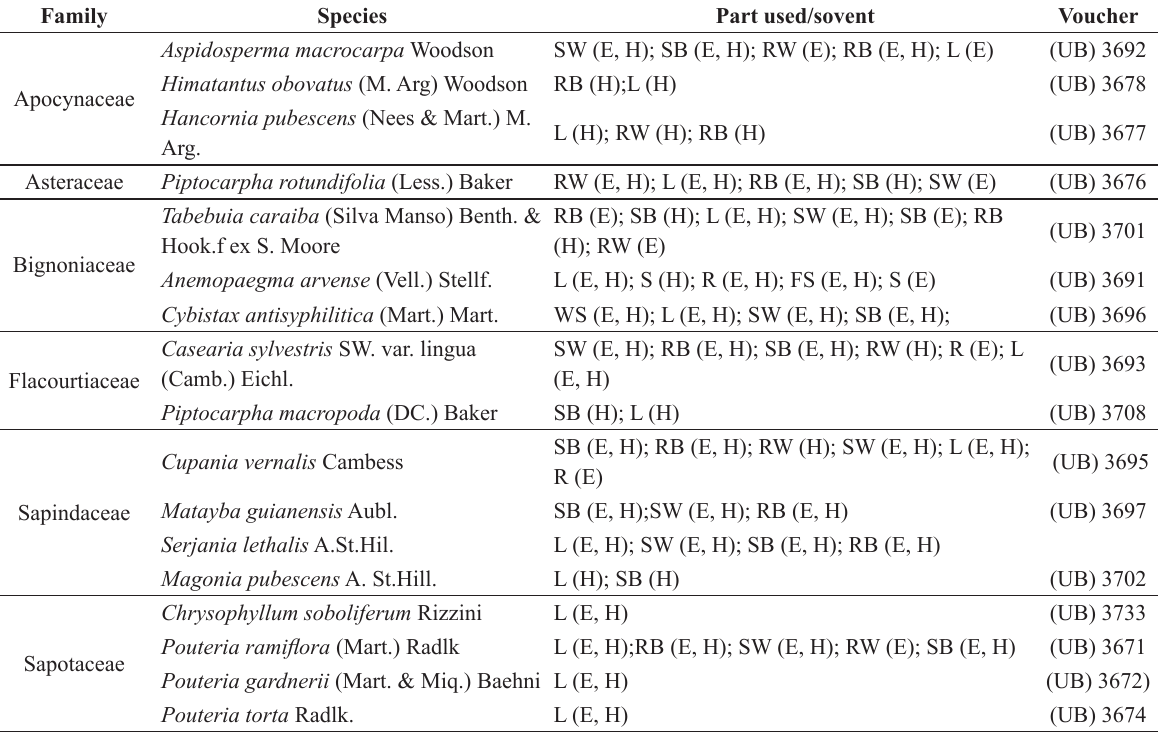
Family, plant species investigated, part used/solvent and voucher